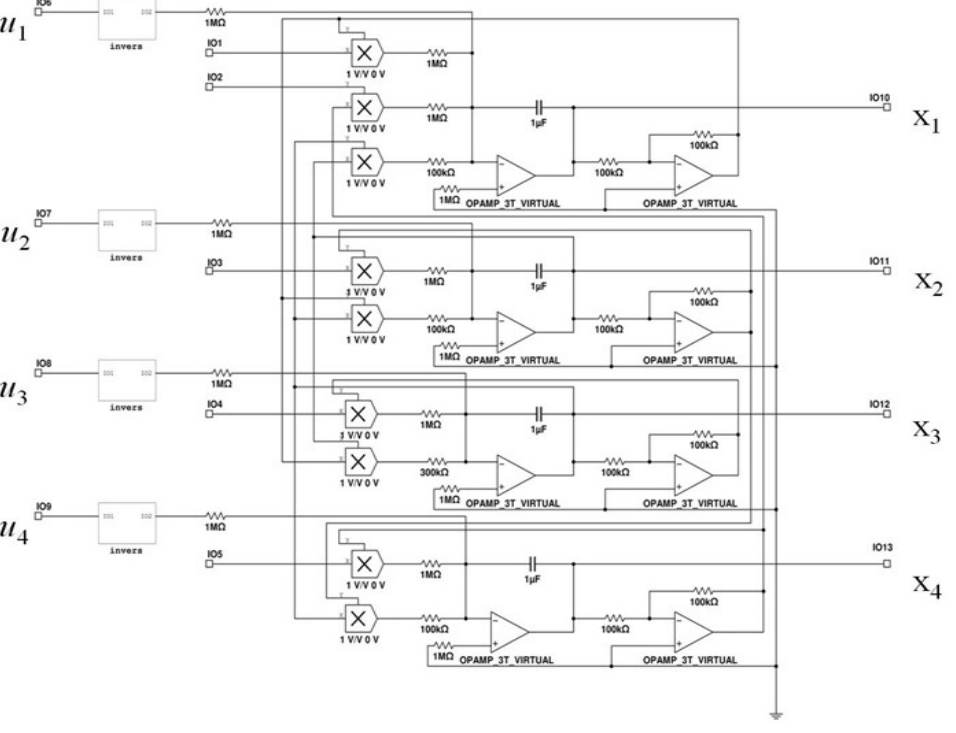
Figure 10. Circuit configuration of the slave system.